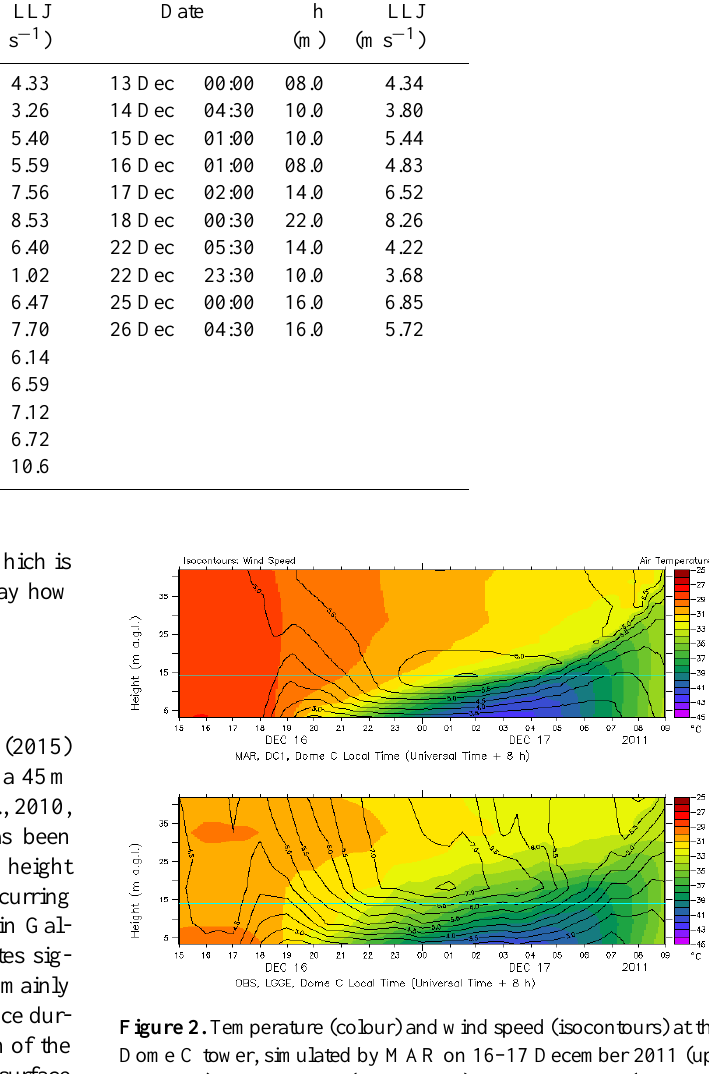
Table 1. Observed and simulated LLJs at Dome C during OPALE. h is the height of the LLJ. Observation Simulation